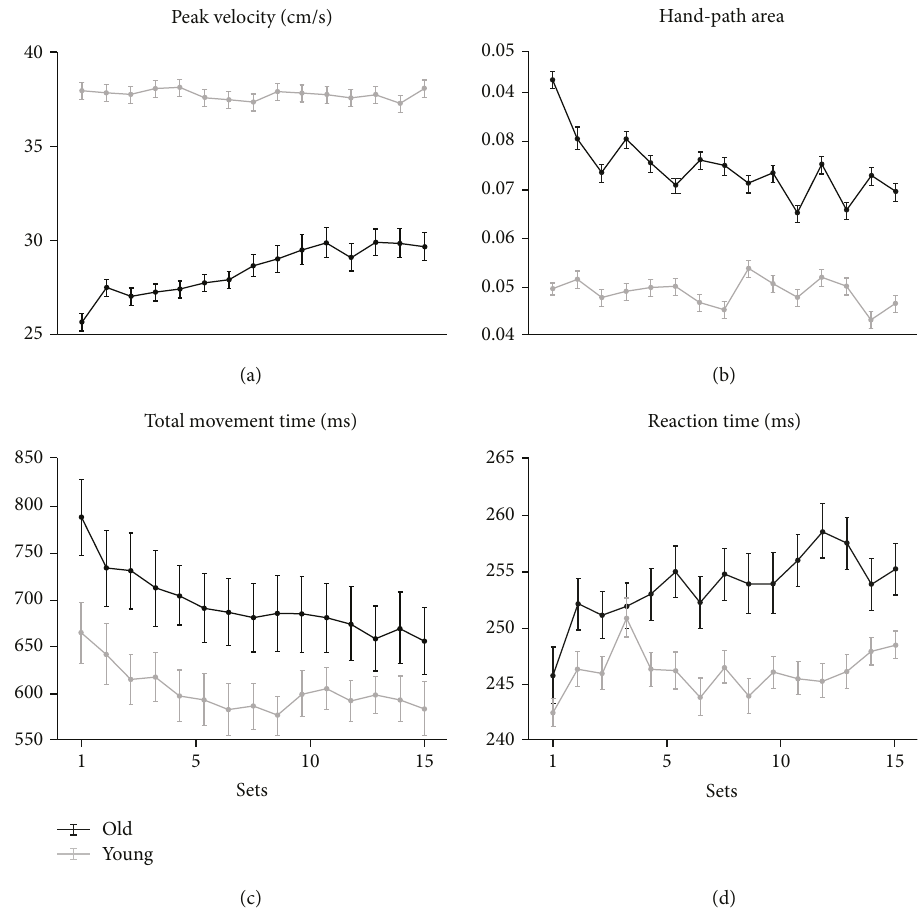
Figure 2: Average of kinematic measures of each set (56 movements each) for the younger (grey lines and dots) and older (black lines and dots) groups. The vertical bars represent standard errors of the